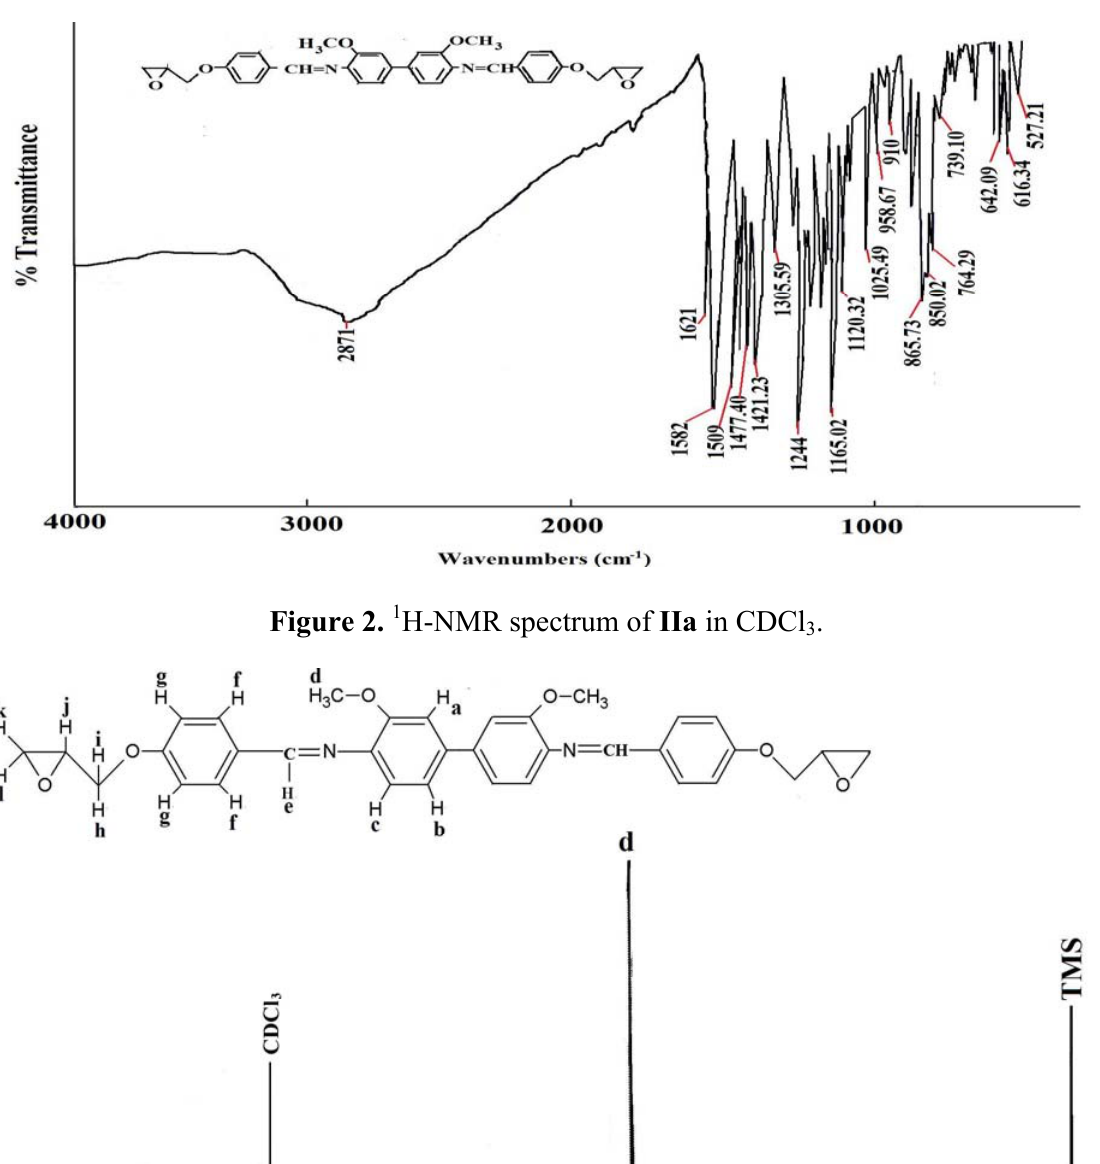
Figure 1. FT-IR spectrum of compound IIa .